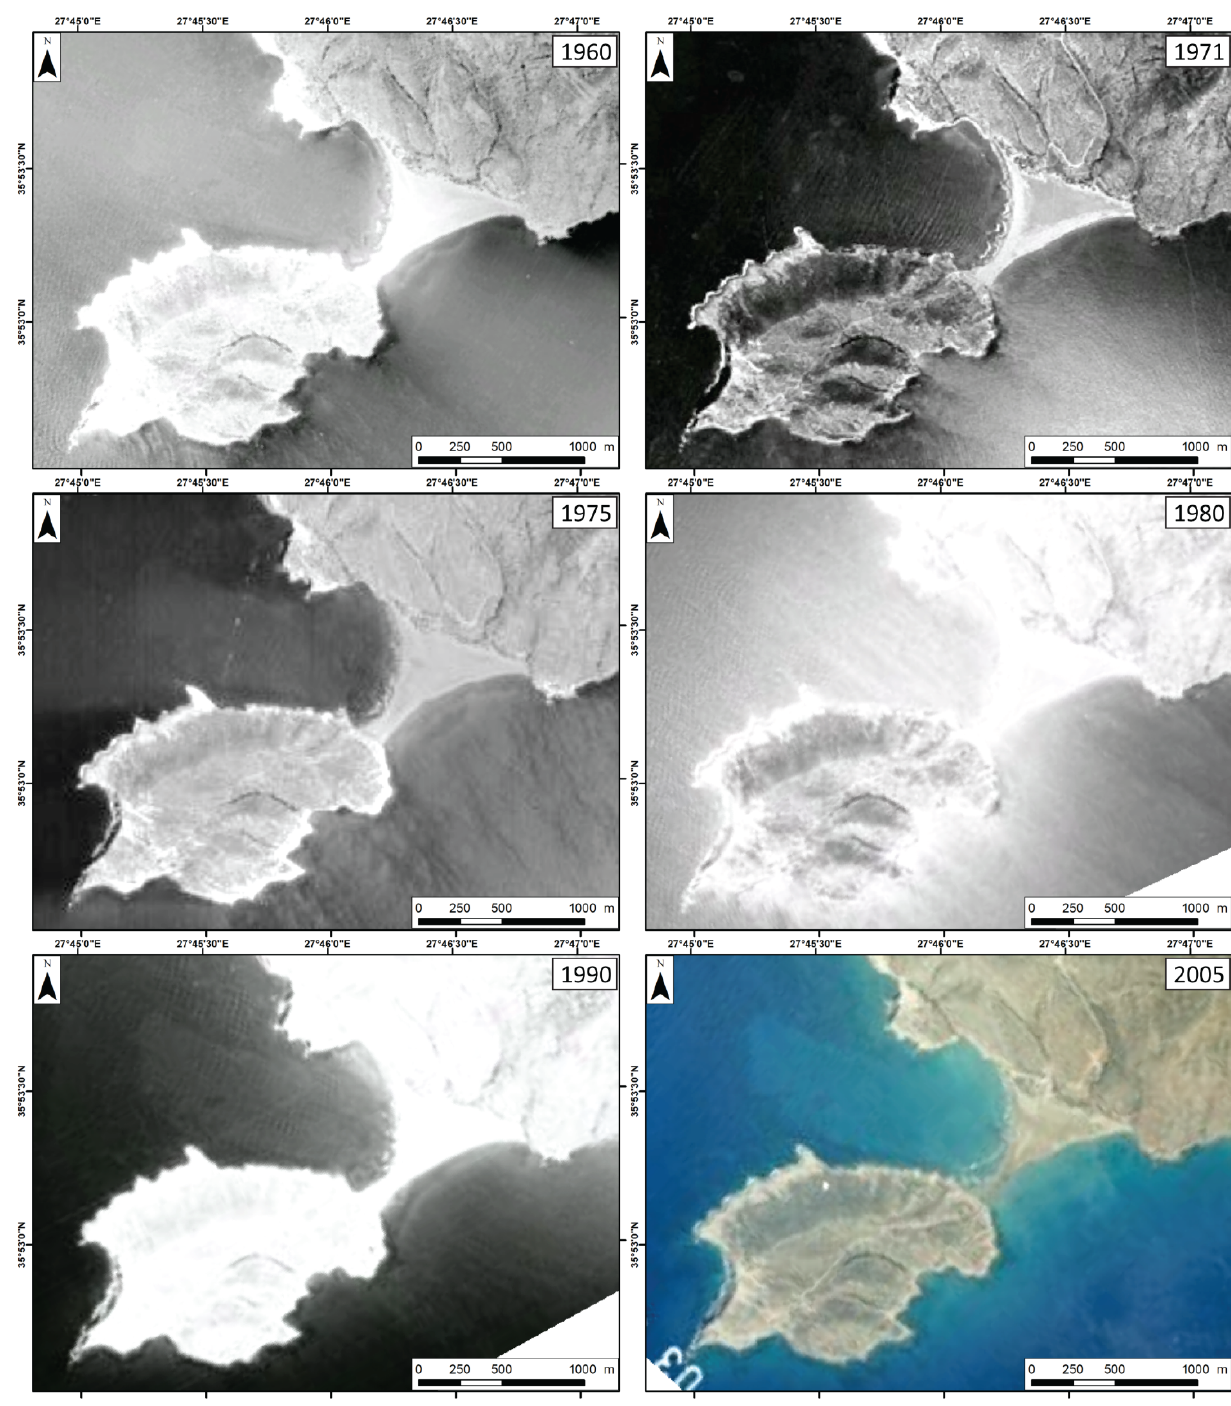
Figure 2. Aerial photos showing the changeable shape of Prasonisi’s tombolo [24]. Figure created in